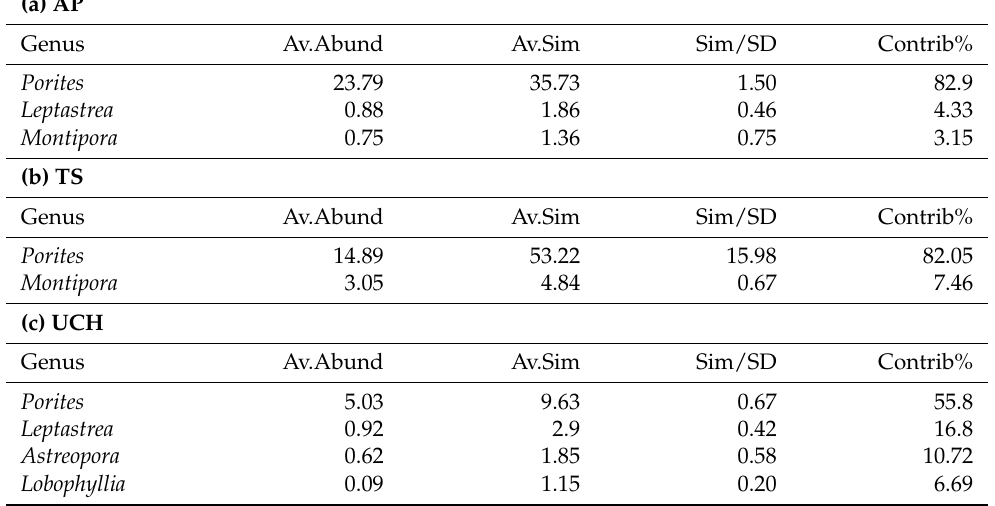
Table 3. List of coral genera that contributed to ≈ 90% of cumulative similarity within each region based on SIMPER analysis on the Bray–Curtis similarity for (a) the AP region, (b) the TS region, and (c) the UCH sites. The heading of each column shows “Av.Abund”, average cover (%); “Av.Sim”, average similarity contribution; “Sim/SD”, ratio of the average similarity contribution to the standard deviation of similarity contribution; and “%Contrib”, percentage of the contribution by the genus to the within-group